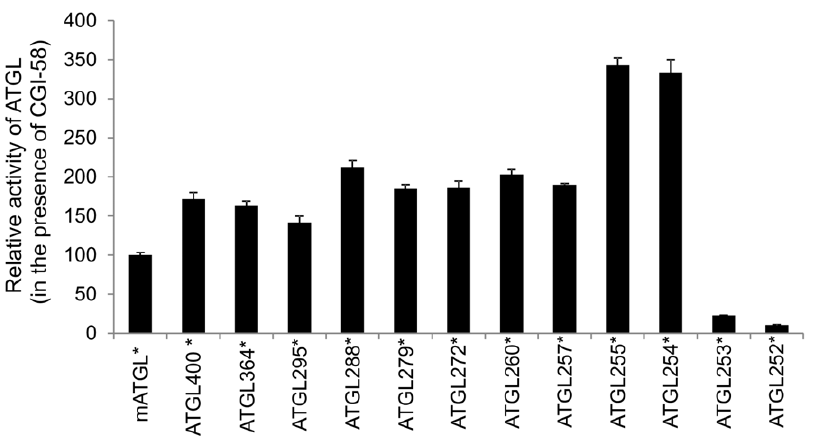
Figure 4. CGI-58 stimulates C-terminal truncation variants of ATGL including ATGL254. TG hydrolase assay with different C-terminal truncations of ATGL, in the presence (*) of purified CGI-58, was performed as described in Figure 2. TG hydrolase activities were normalized to that of full length ATGL (=100%). Data are presented as mean + SD. Results are representative of three independent experiments.